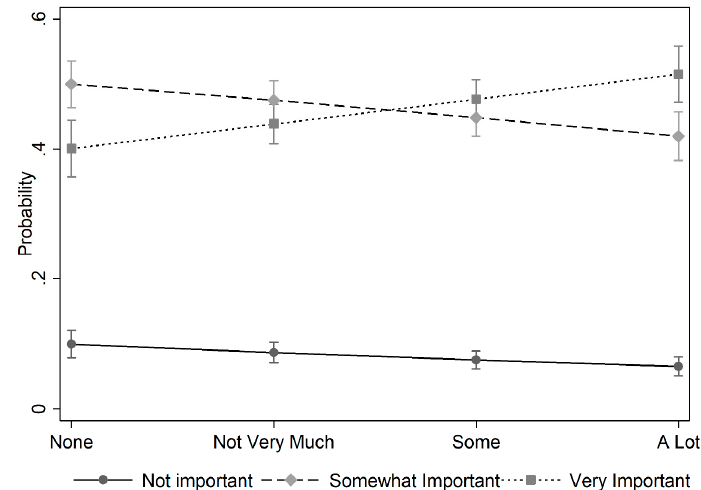
Figure 7. Probabilities for the position on supporting black undocumented immigrants by linked fate.